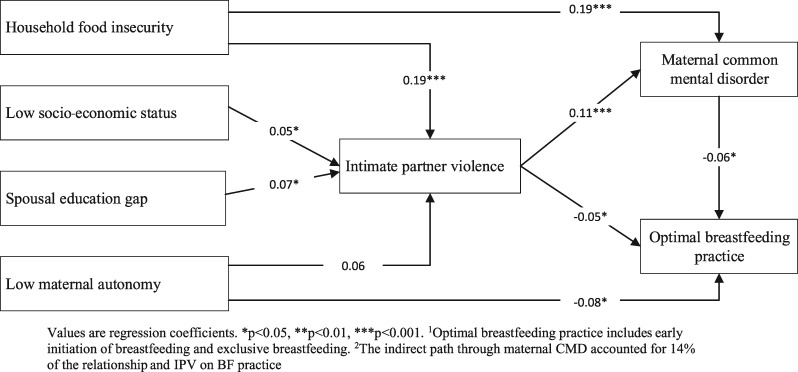
Inter-relationships between determinants factors, IPV, maternal CMD and breastfeeding practices1,2. 1Optimal breastfeeding practice includes EIBF and EBF. 2The indirect path through maternal CMD accounted for 14% of the relationship between IPV and breastfeeding practice